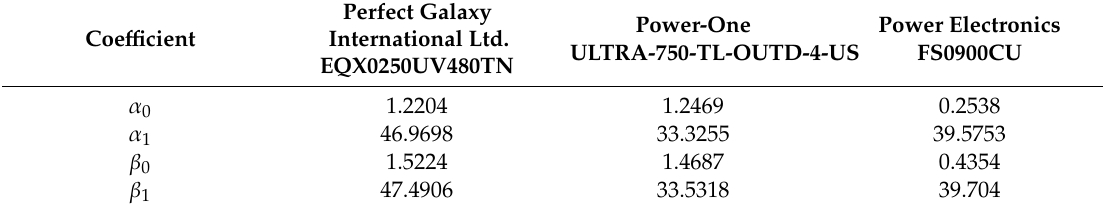
Table 6. Dupont coe ffi